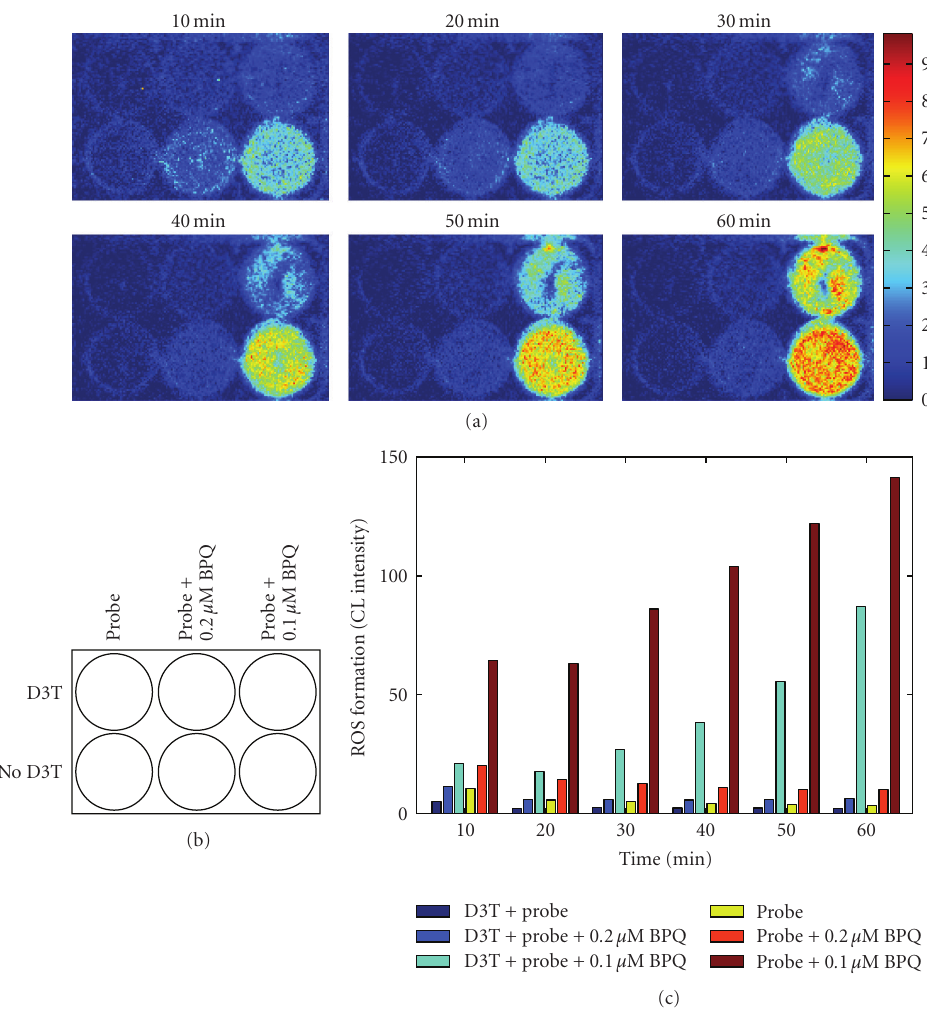
Figure 6: In situ real-time imaging of the e ff ects of D3T pretreatment on basal and BPQ-stimulated ROS formation in cultured monolayers of H9c2 cardiomyocytes. H9c2 cells were treated with or without 100 μ M D3T for 48 hours in culture medium before CL imaging experiment. For CL imaging, confluent cells in culture were washed once with PBS followed by addition of 2 mL PBS containing 0.2 and 1 μ M BPQ or other reagents, as described under Materials and Methods section. (a) Representative CL images acquired at the indicated time points; (b) layout of treatment groups, probe refers to luminol/HRP, (c) quantification of time-dependent ROS formation by luminol/HRP-amplified CL imaging. Data in (c) represent averages of two